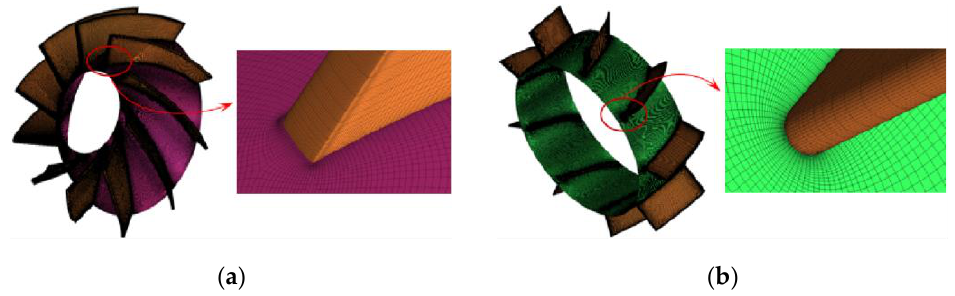
Figure 3. Grid model of diagonal flow fan. ( a ) Moving blade area grid. ( b ) Guide vane area grid.